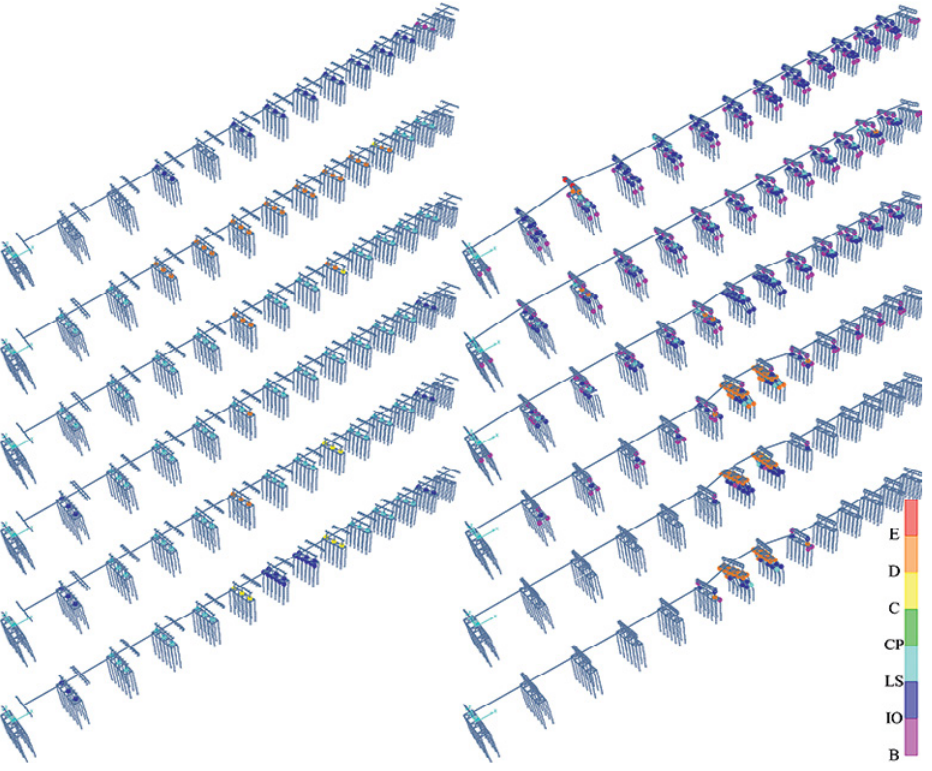
a) longitudinal direction b) transverse Figure 5. Plastic hinges locations at failure for scouring depths